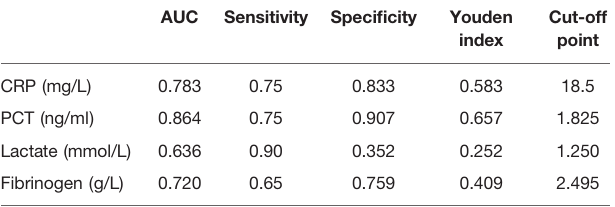
TABLE 4 | Diagnostic characteristics of CRP, PCT, lactic acids, and fi brinogen for implementing surgical treatment in NEC